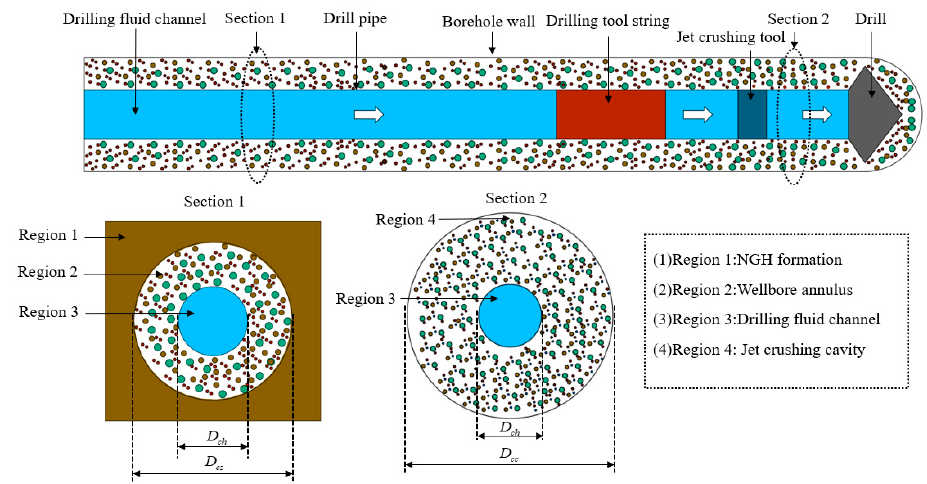
Figure 5. Schematic diagram of slurry movement in horizontal section of traditional method.